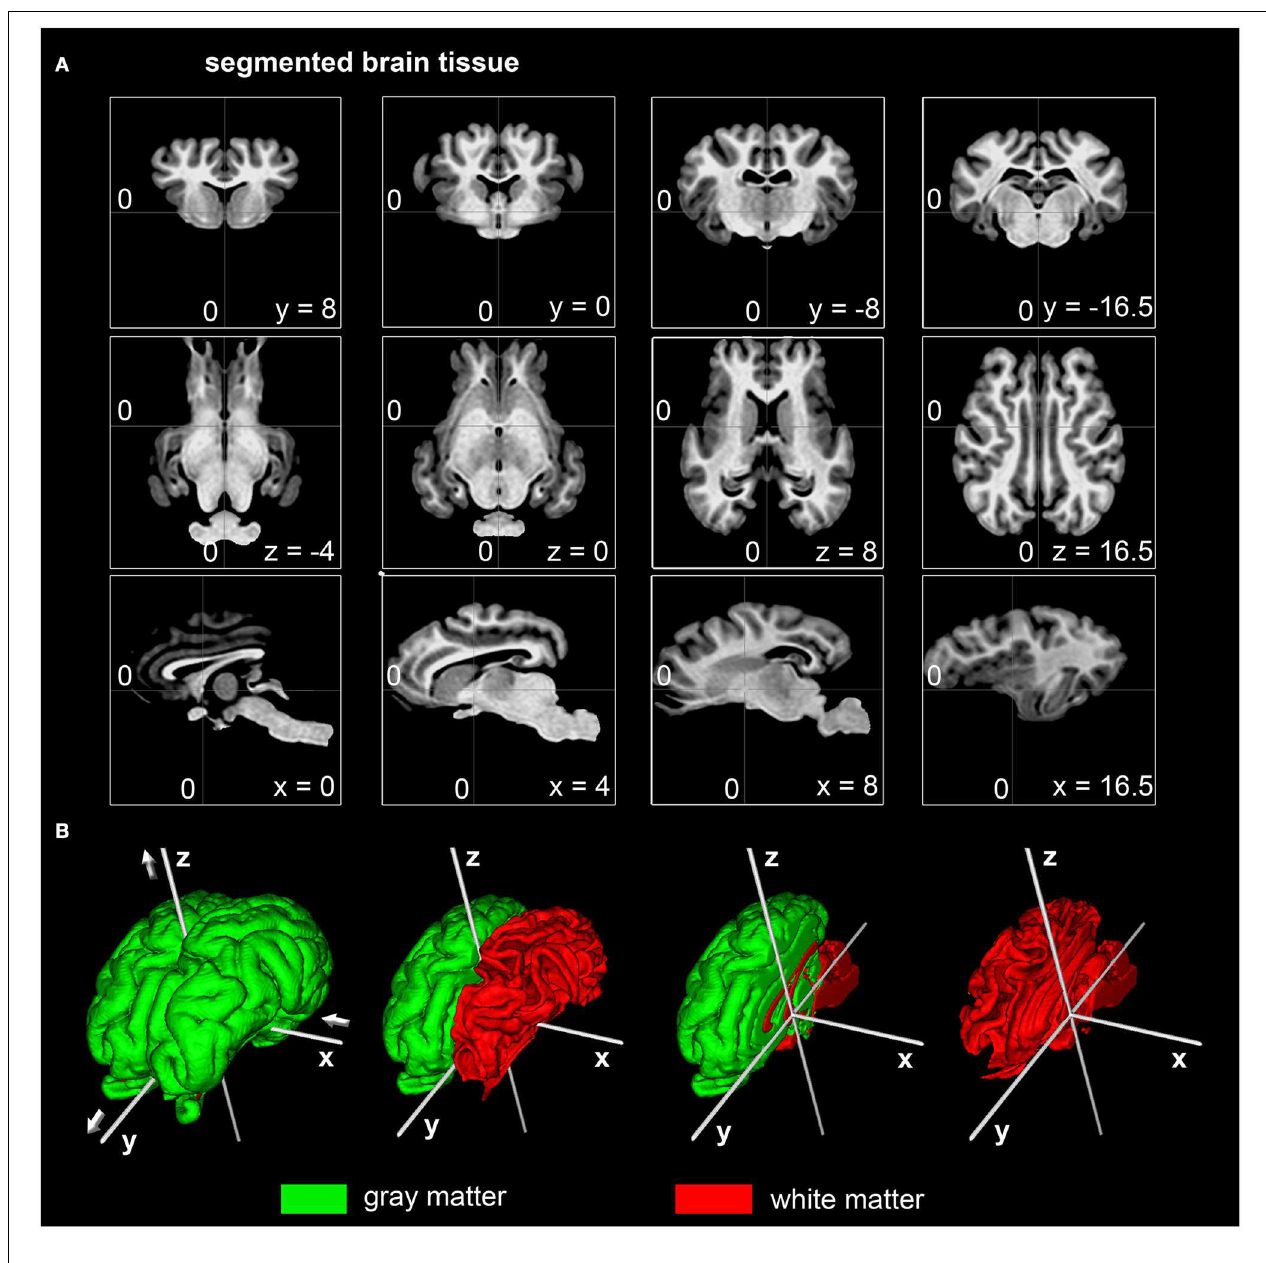
reconstruction for gray and white matter with the applied stereotaxic coordinate system (white): Values of the x-axis increase from left (negative) to right (positive) while the y-axis increase from caudal (negative) to rostral (positive). Values of the z-axis rise from ventral (negative) to dorsal